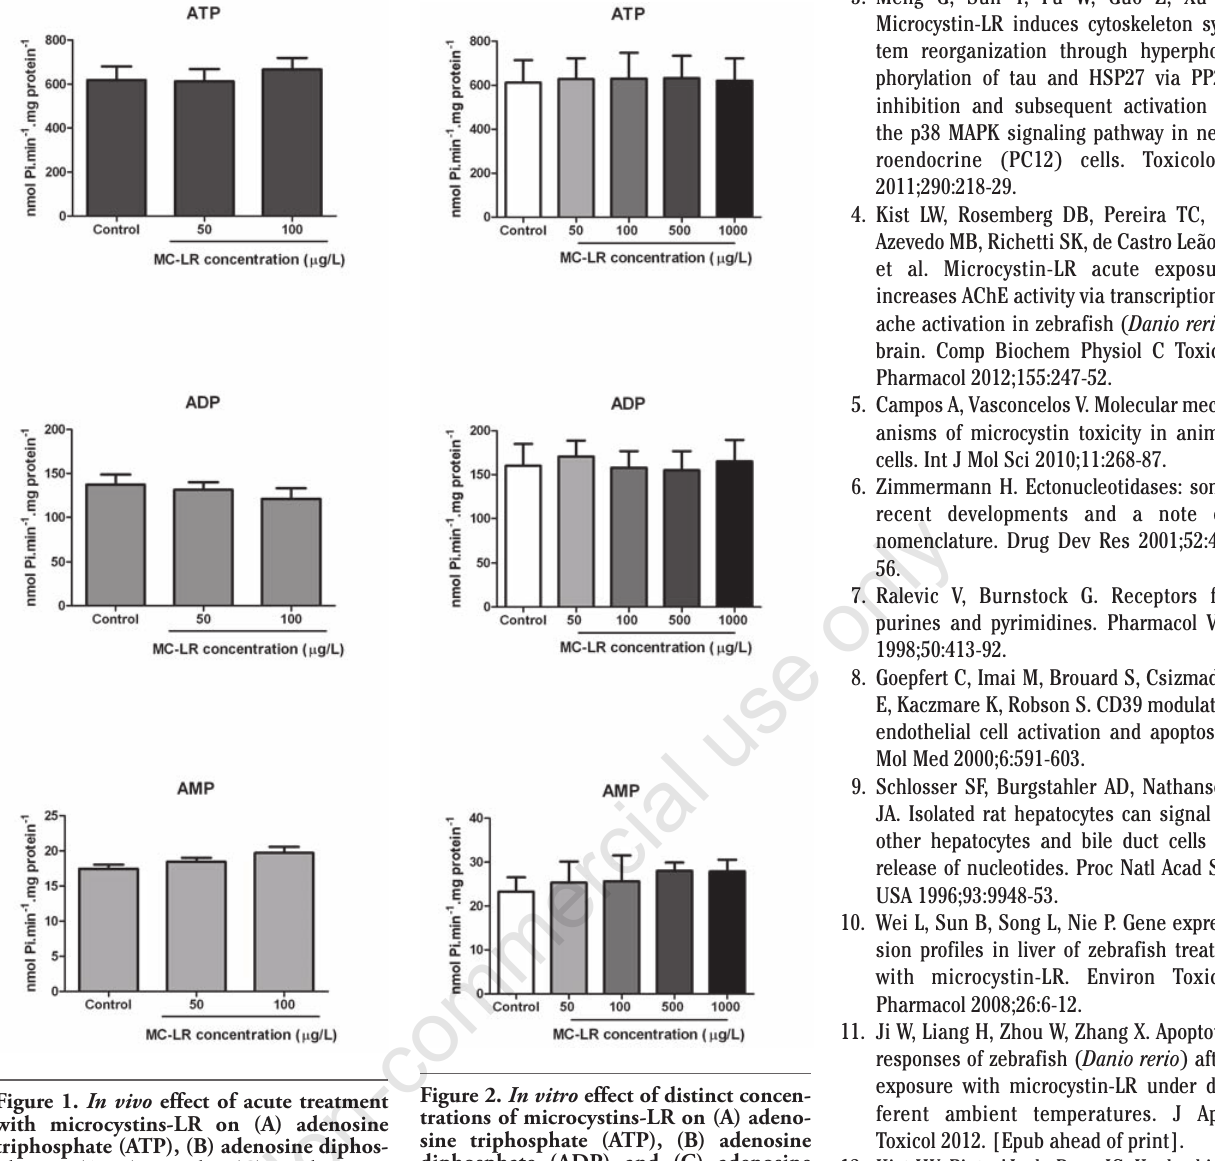
Figure 1. In vivo effect of acute treatment with microcystins-LR on (A) adenosine triphosphate (ATP), (B) adenosine diphos- phate (ADP) and (C) adenosine monophosphate (AMP) hydrolysis in zebrafish brain membranes. Bars represent the mean±SEM. Data were analyzed by one-way ANOVA, P<0.05.The specific enzyme activity is reported as nanomole of inorganic phosphate released per minute per milligram of protein.